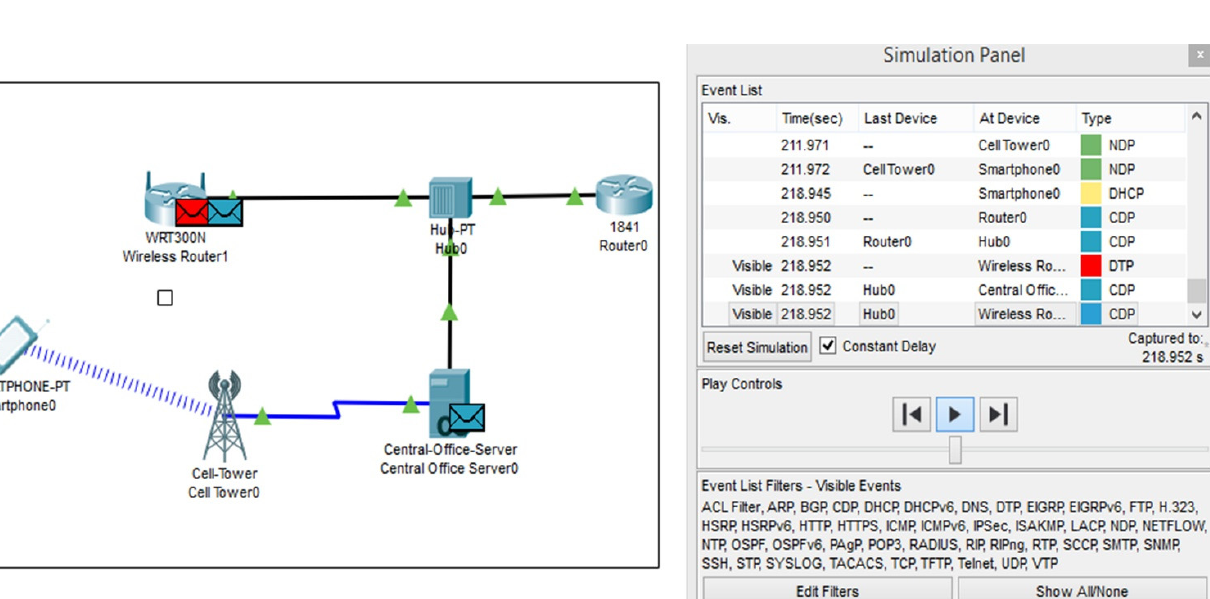
Figure 10. LoRa simulation platform with simulation parameters.